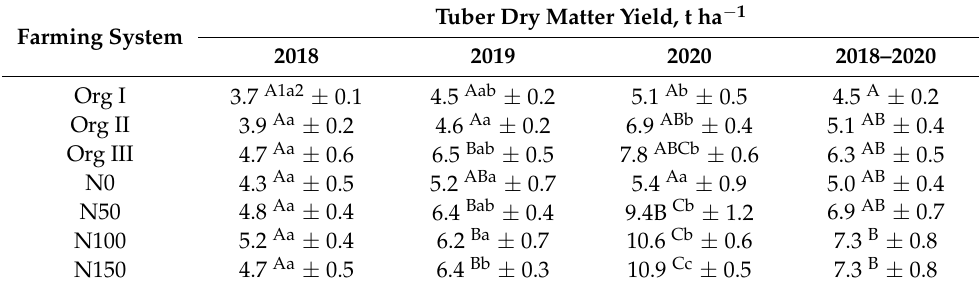
Table 3. Average dry matter yield of potato tubers depending on the farming system. Farming